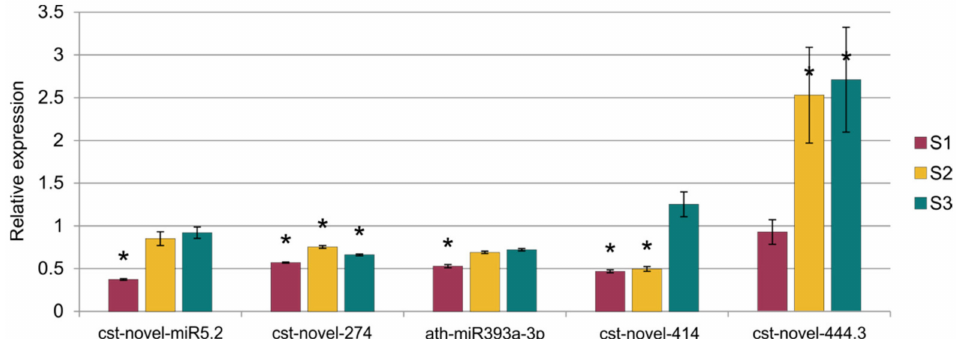
Figure 7. Results of the relative expression analysis of five miRNAs. Statistically important differences are marked with